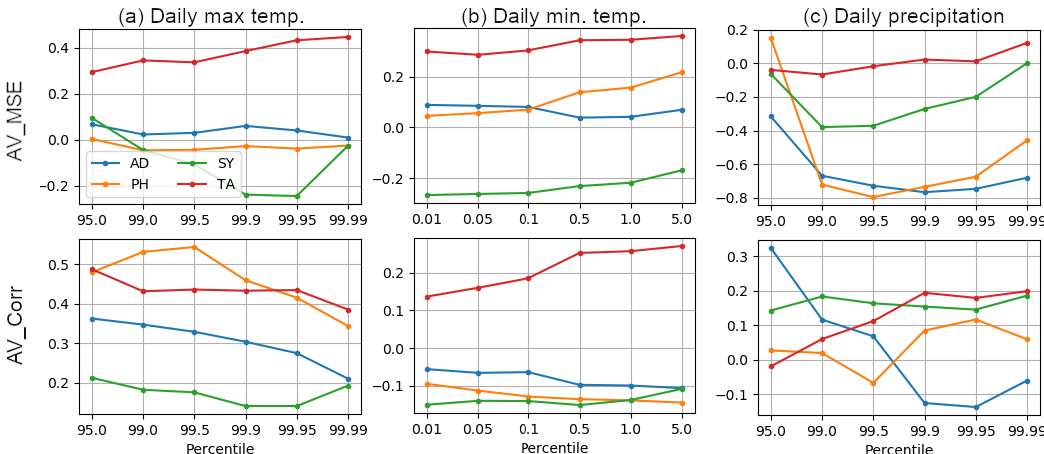
Figure 11. Added-value (AV) analysis of the (a) warm extreme of daily maximum temperature, (b) cold extreme of daily minimum temper- ature, and (c) wet extreme of daily precipitation for all four BARRA-C